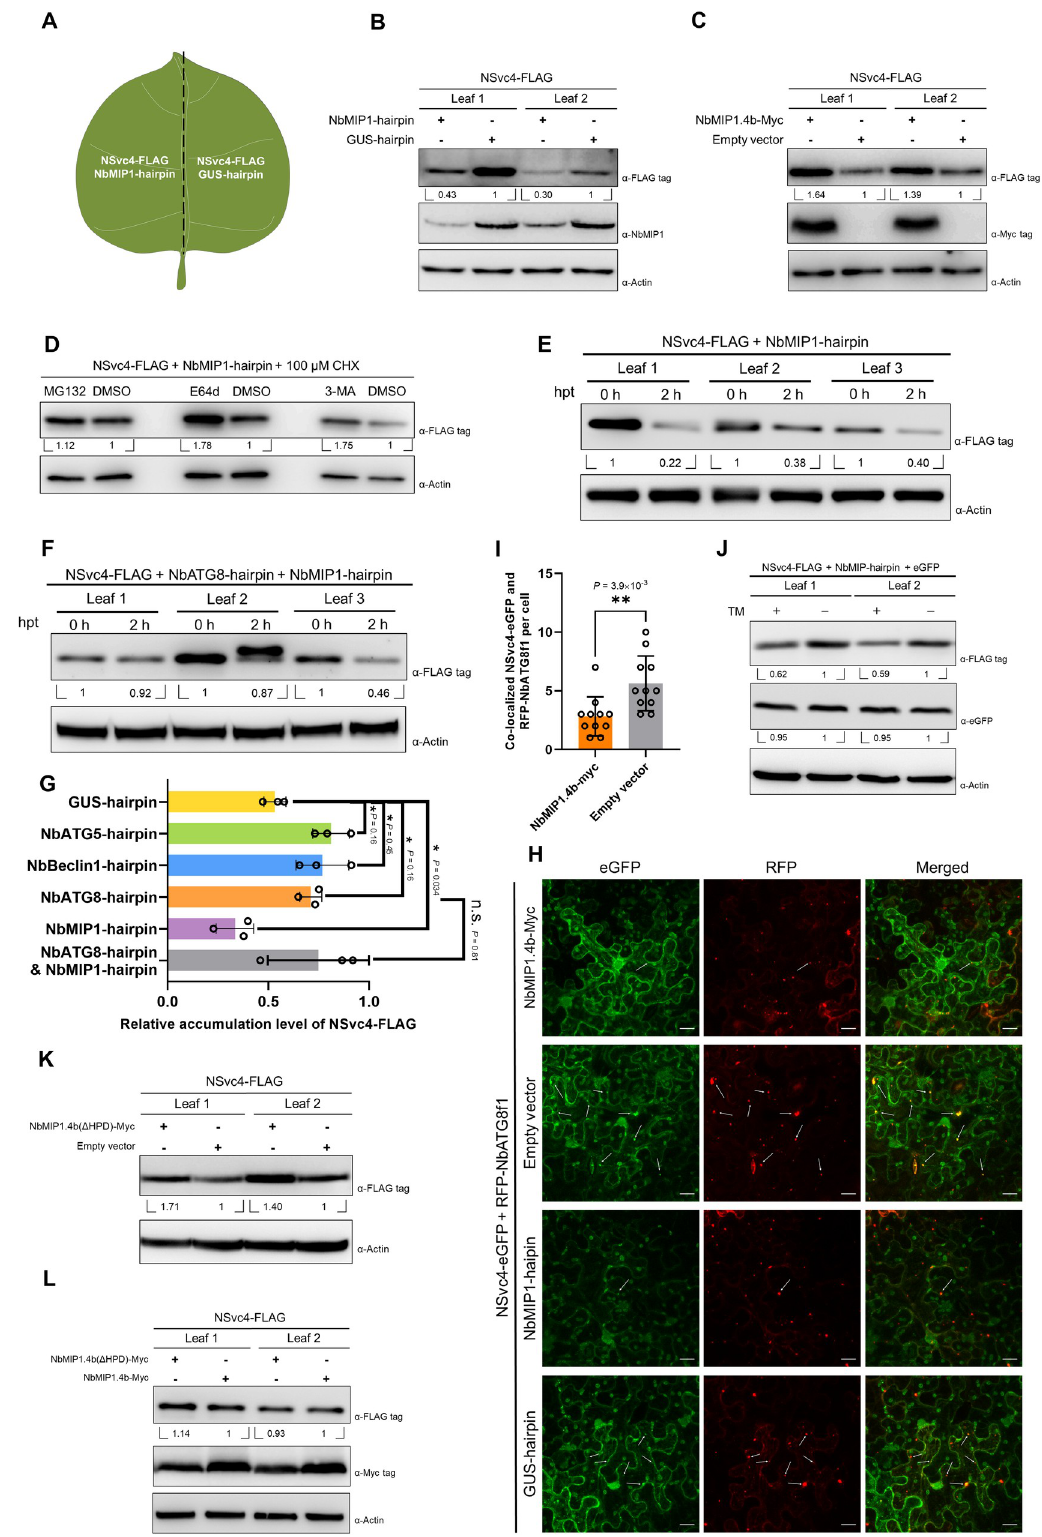
Fig 4. NbMIP1.4b stabilizes NSvc4 in an HSP70 chaperone-independent manner, and silencing NbMIP1s promotes NSvc4 degradation. (A, B and D) Silencing NbMIP1s impairs the stability of NSvc4. NSvc4-FLAG was co-expressed